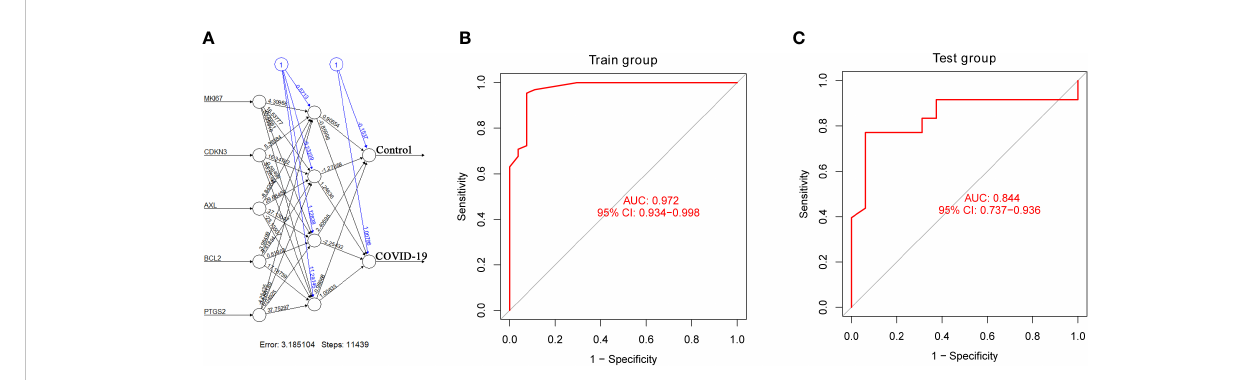
FIGURE 6 Construction and veri fi cation of an arti fi cial neural network model. (A) Visualization of the arti fi cial neural network model. (B, C) ROC curve evaluation of the train and test